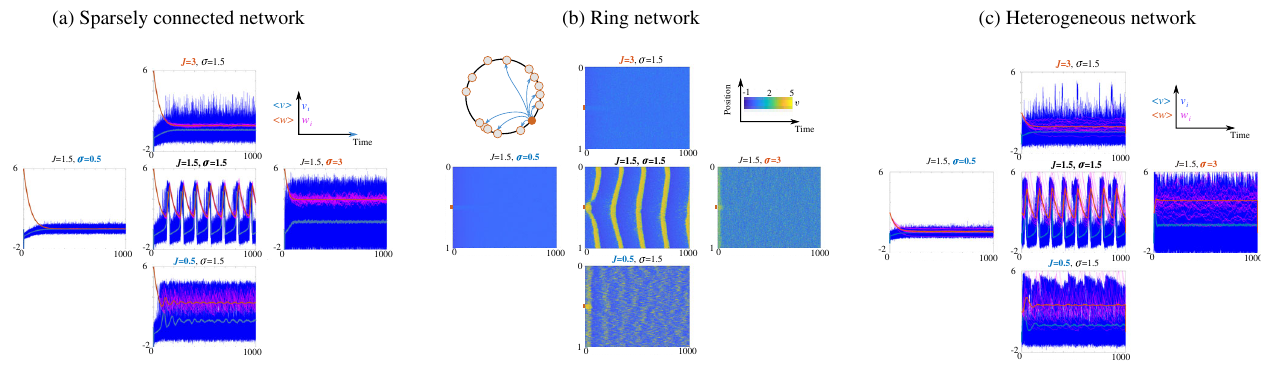
FIG. 9. Noise-induced synchronization in heterogeneous FitzHugh-Nagumo networks model, with n ¼ 4000 neurons [ n ¼ 2000 for spatial networks in (b)], a ¼ 4 , b ¼ 4 , ε ¼ 0 . 01 , and I ¼ 0 , for various values of the coupling strength J and noise level σ . (a) Sparsely connected networks with probability of connection p ¼ 0 . 6 , and connectivity amplitude J=p . Same color code as in Fig. 1. The graphs represent 10 randomly chosen trajectories of voltage and recovery variable as well as their statistical mean. The system shows an almost identical phenomenology as in the homogeneous network. (b) Spatially extended network with local exponential coupling, i.e., with a probability of connection between two neurons at a distance D given by e − D= δ with δ ¼ 0 . 02 (see upper left inset for a sketch of the local coupling) and a weight of connection equal to J= ¯ p , where ¯ p is the average connectivity level of a given neuron. Initial condition was set up with an average excited region of 5% of the network (100 cells upon 2000). We observe that the phenomenology persists and that a local theory of pioneers and resting neurons seems at play in the emergence of patterns of synchrony for J ¼ 1 . 5 and σ ¼ 1 . 5 . (c) Heterogeneous elements. Neurons have heterogeneous excitability levels a where ξ x;i for x ¼ a , I are white noise, i.e., independent and identically distributed normal centered variables, σ While the dispersion of neurons voltage and recovery variable seems now broader, the phenomena are exactly